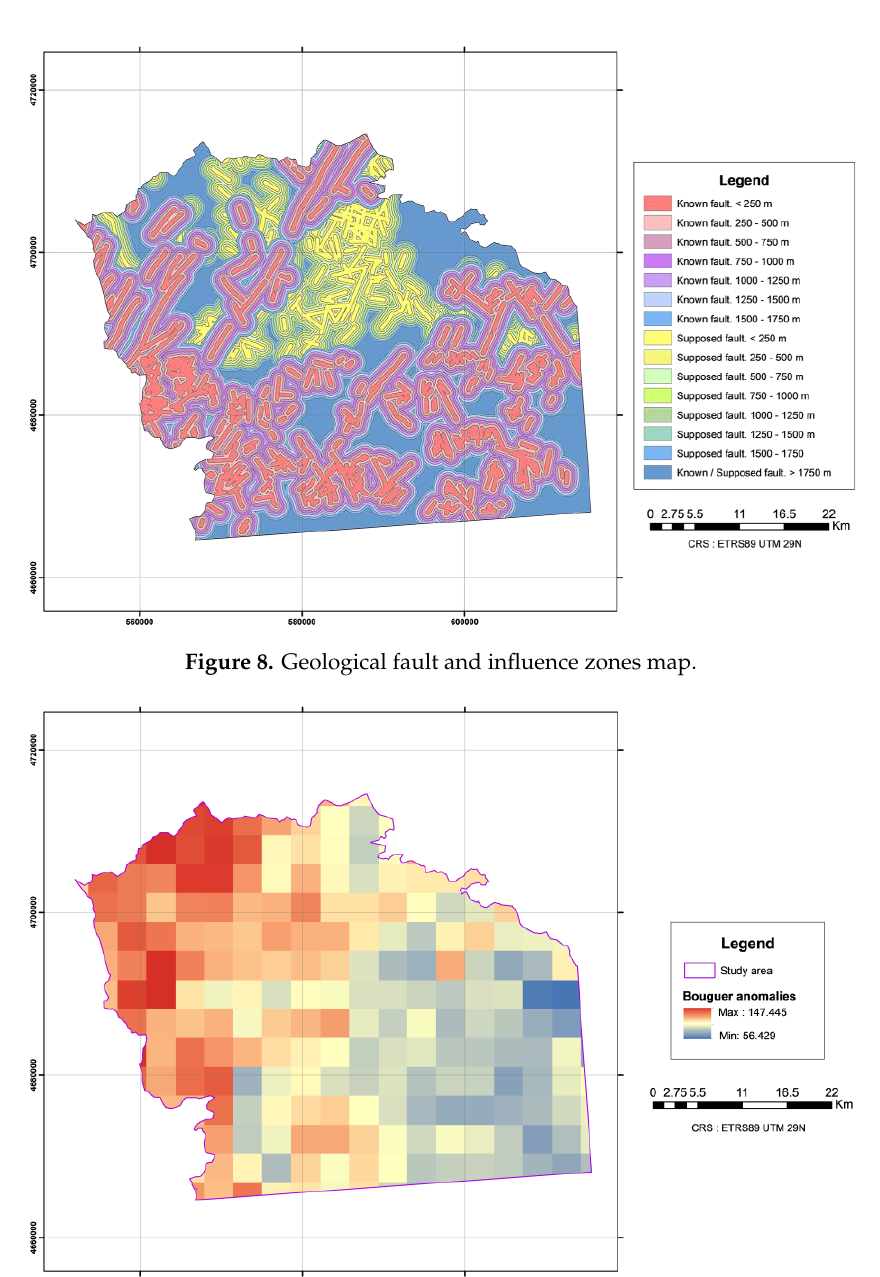
Figure 7. Geological map with the six reclassified informational classes.